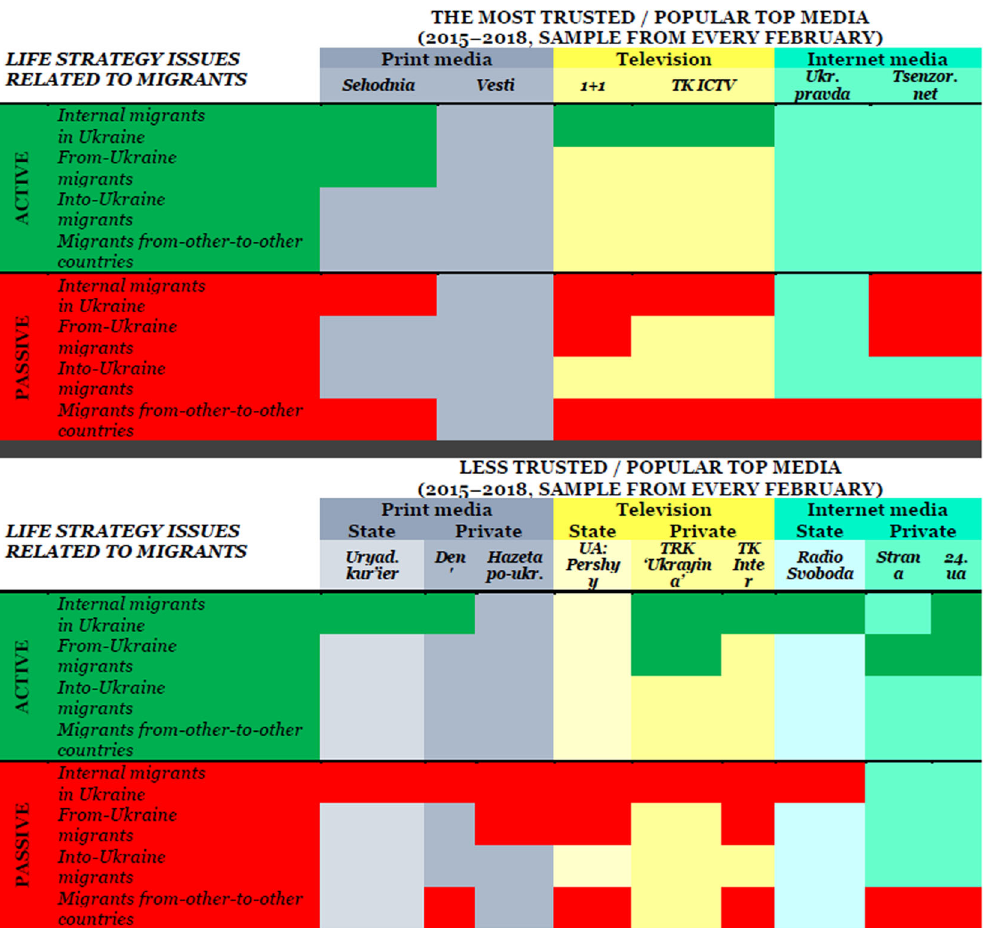
Fig. 8 Hidden images of migrants ’ ‘ activity ’ and ‘ passivity ’ in different types and subtypes of Ukrainian top media (2015 – 2018, sample from every February messages). Source: A. Tashchenko ’ s elaboration based on qualitative content analysis (by L. Yuzva and A. Tashchenko), analysis of discourse positions and sociocognitive critical discourse analysis (by A. Tashchenko) of media messages. Data source: The Center for Content Analysis research based on quantitative media content analysis, 2019. The comparative illustration demonstrates the emergence of dynamics of implications about life strategies of four migrant groups in the media with different discourse positions: green color indicates the presence or absence of implications about an active life strategy; red color indicates the presence or absence of implications about a passive life strategy. All other colors are used to delimit areas for the sake of visual